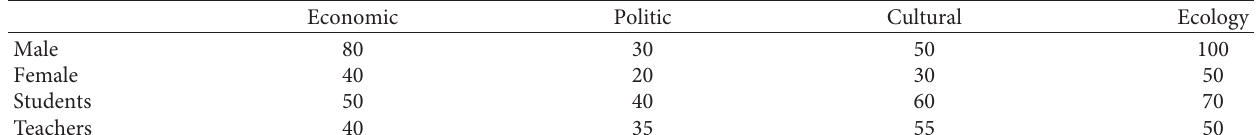
Table 2: Respondents’ supportive attitudes towards global information.